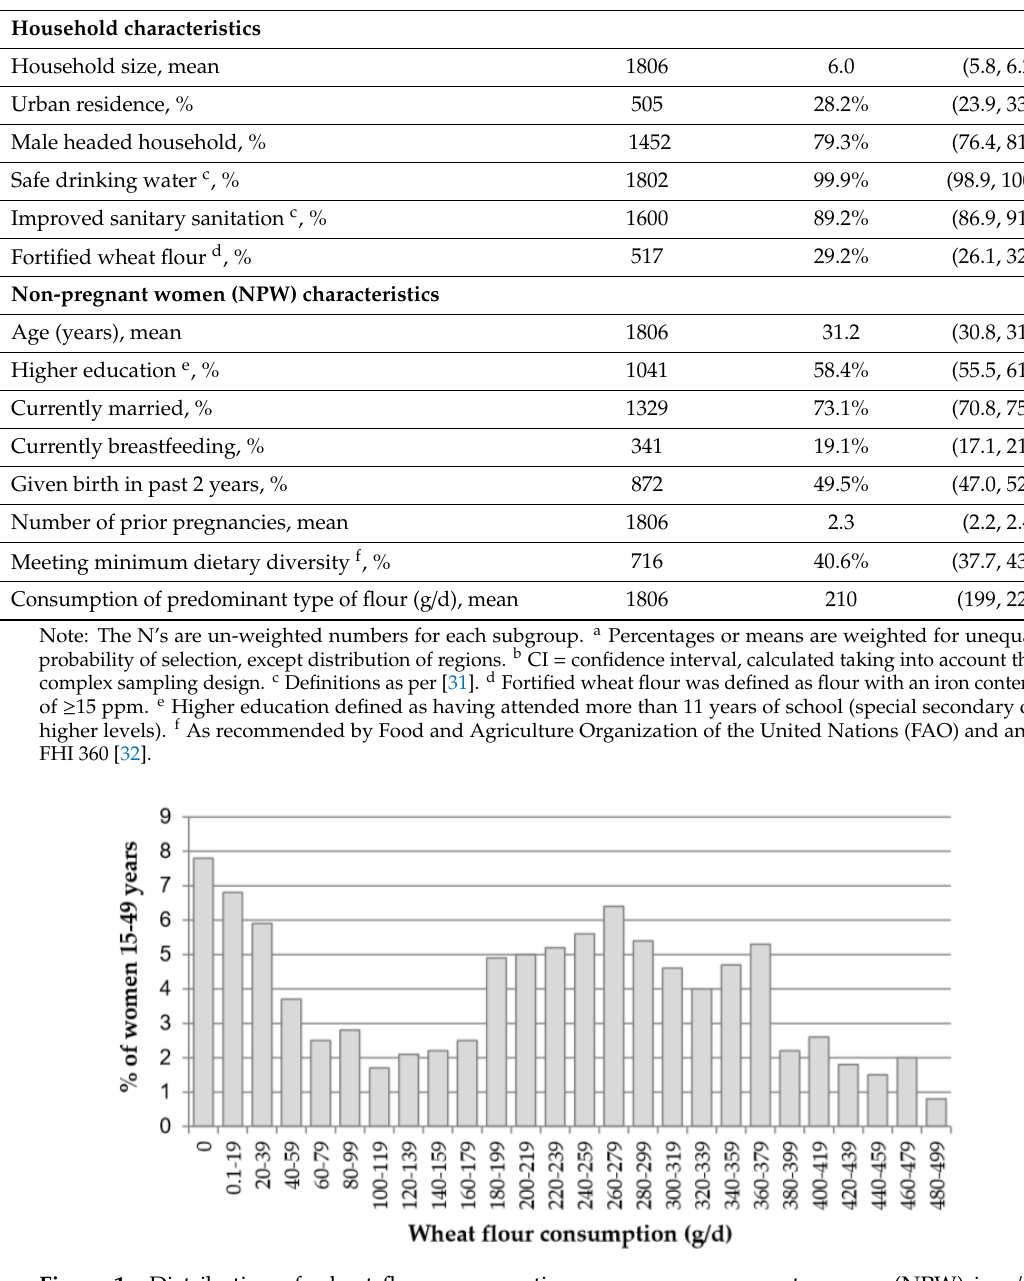
Figure 1. Distribution of wheat flour consumption among non-pregnant women (NPW) in g / d, Uzbekistan Uzbekistan 2017